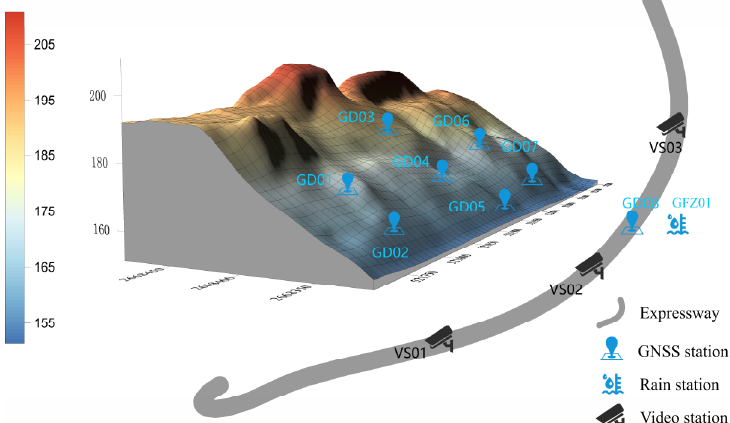
Figure 4. GD01 – GD08 are ground displacement monitoring stations, GD01 – GD07 are lo- cated on the landslide surface and are hereinafter referred to as monitoring stations. GD08 is located on the roadside opposite to the landslide and acts as a reference station for the relative stability. The rainfall monitoring station GFZ01 and the monitoring station GD08 are located at the same location. In view of the large span of the landslide, three cameras, VS01 – VS03, are arranged along the road to achieve comprehensive video coverage of the landslide and the road. The monitoring content and methods are listed in Table 1.